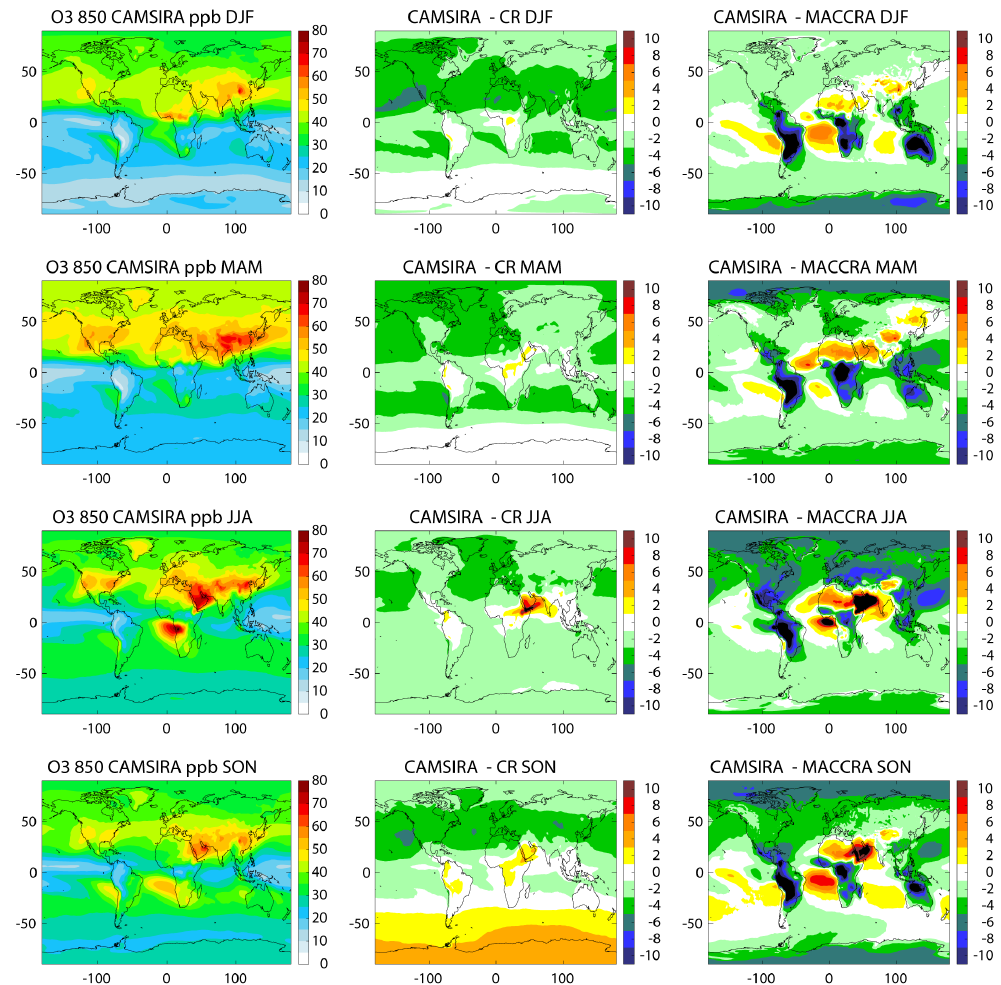
Figure 20. Seasonally averaged ozone at 850hPa (ppb) from CAMSiRA (left) difference between CAMSIRA and the CR (middle) and CAMSiRA and MACCRA (right, 2003–2012) for the seasons DJF (row 1), MAM (row 2), JJA (row 3) and SON (row